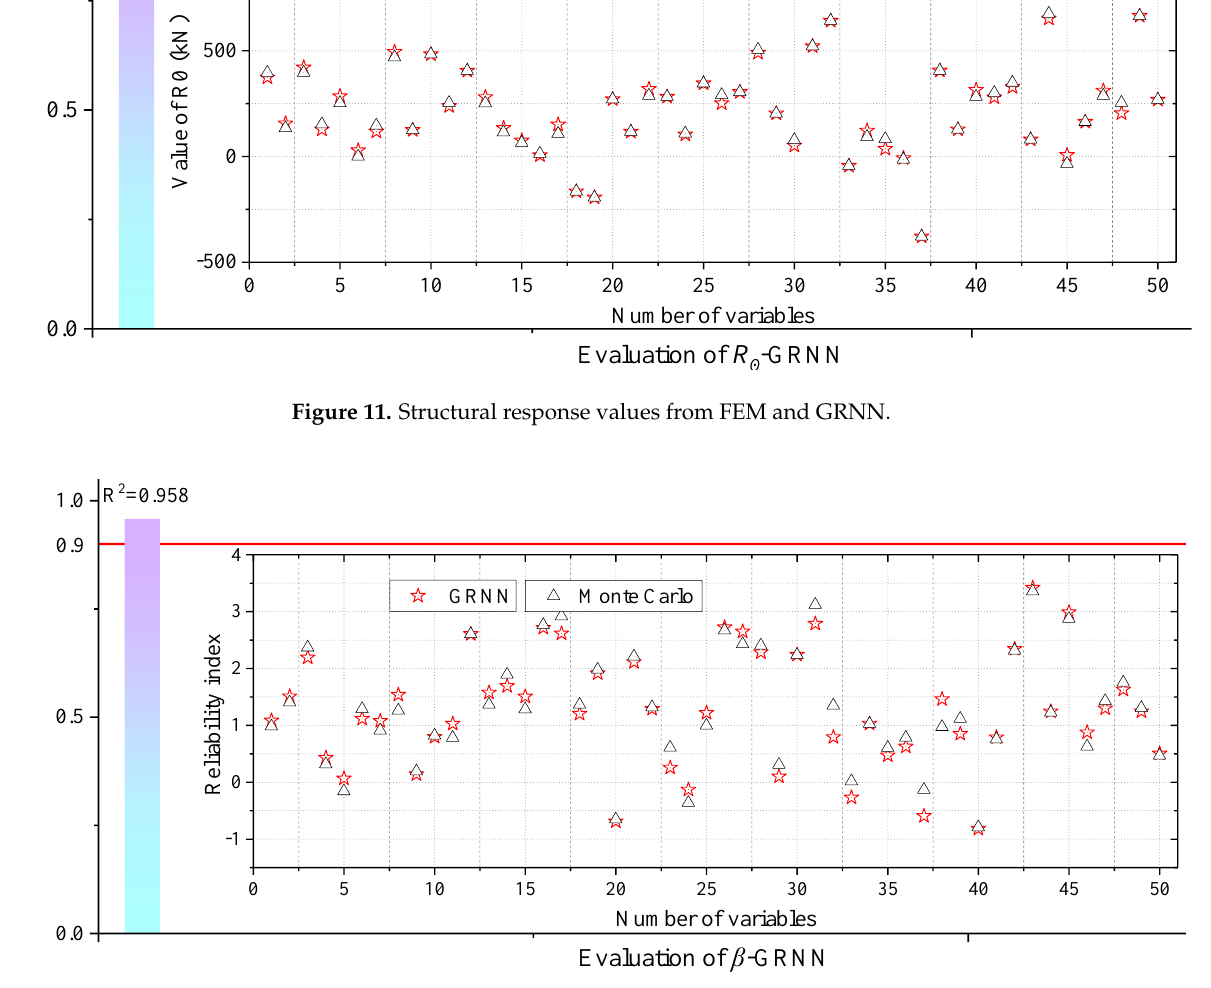
Figure 13. Negative reaction risk assessment under the live load.